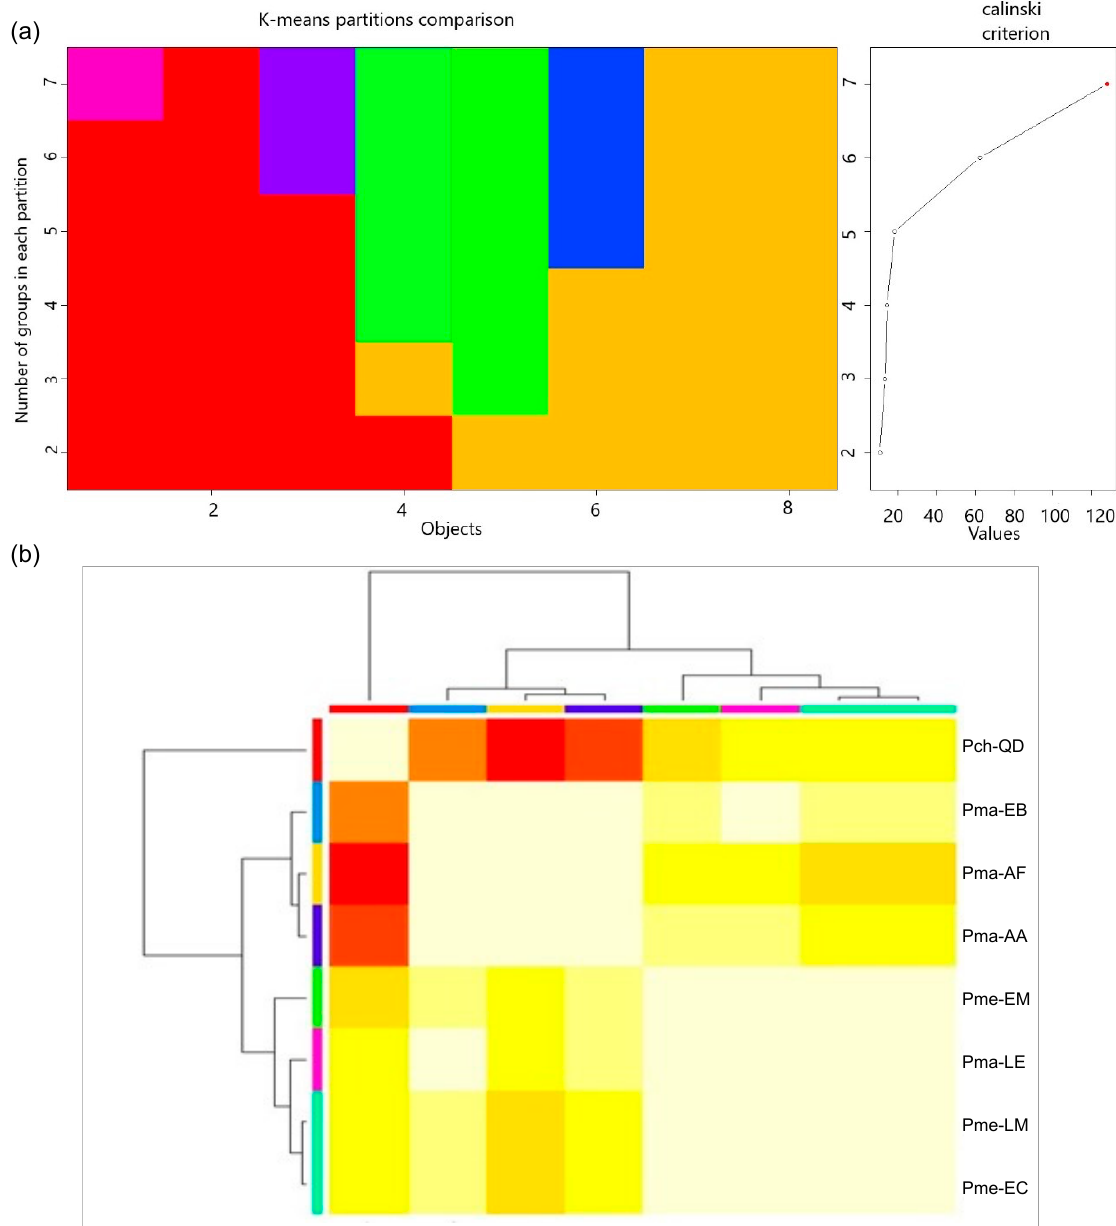
Figure 3. Grouping tests for the eight Picea provenances by seedling diameter, height and survival. Both the Calinski–Harabasz criterion ( a ) and the a ffi nity propagation clustering technique ( q = 1) ( b ) distinguished seven clusters. Pch-QD = P. chihuahuana —Quebrada de los Durán, Pma-AF = P. martinezii —Agua Fr í a, Pma-AA = P. martinezii —Agua Alard í n, Pma-EB = P. martinezii —El Butano, Pma-LE = P. martinezii —La Encantada, Pme-EM = P. mexicana —El Mohinora, Pme-LM = P. mexicana —La Marta, Pme-EC = P. mexicana —El Coahuil ó n. In ( a ) each color represents a different cluster (group); in ( b ), the upper and left color bars indicate the groups, while the inner red-yellow scaled colors indicate the degree of similarity between provenances (the lighter, the more